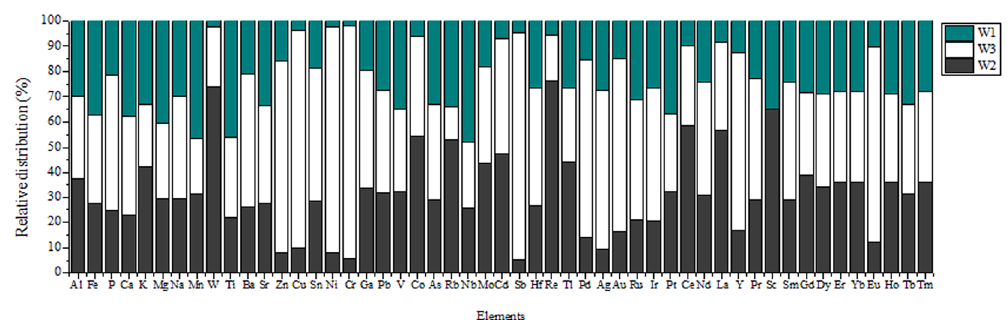
Figure 3. Spatial variations of relative distribution percentages of the target